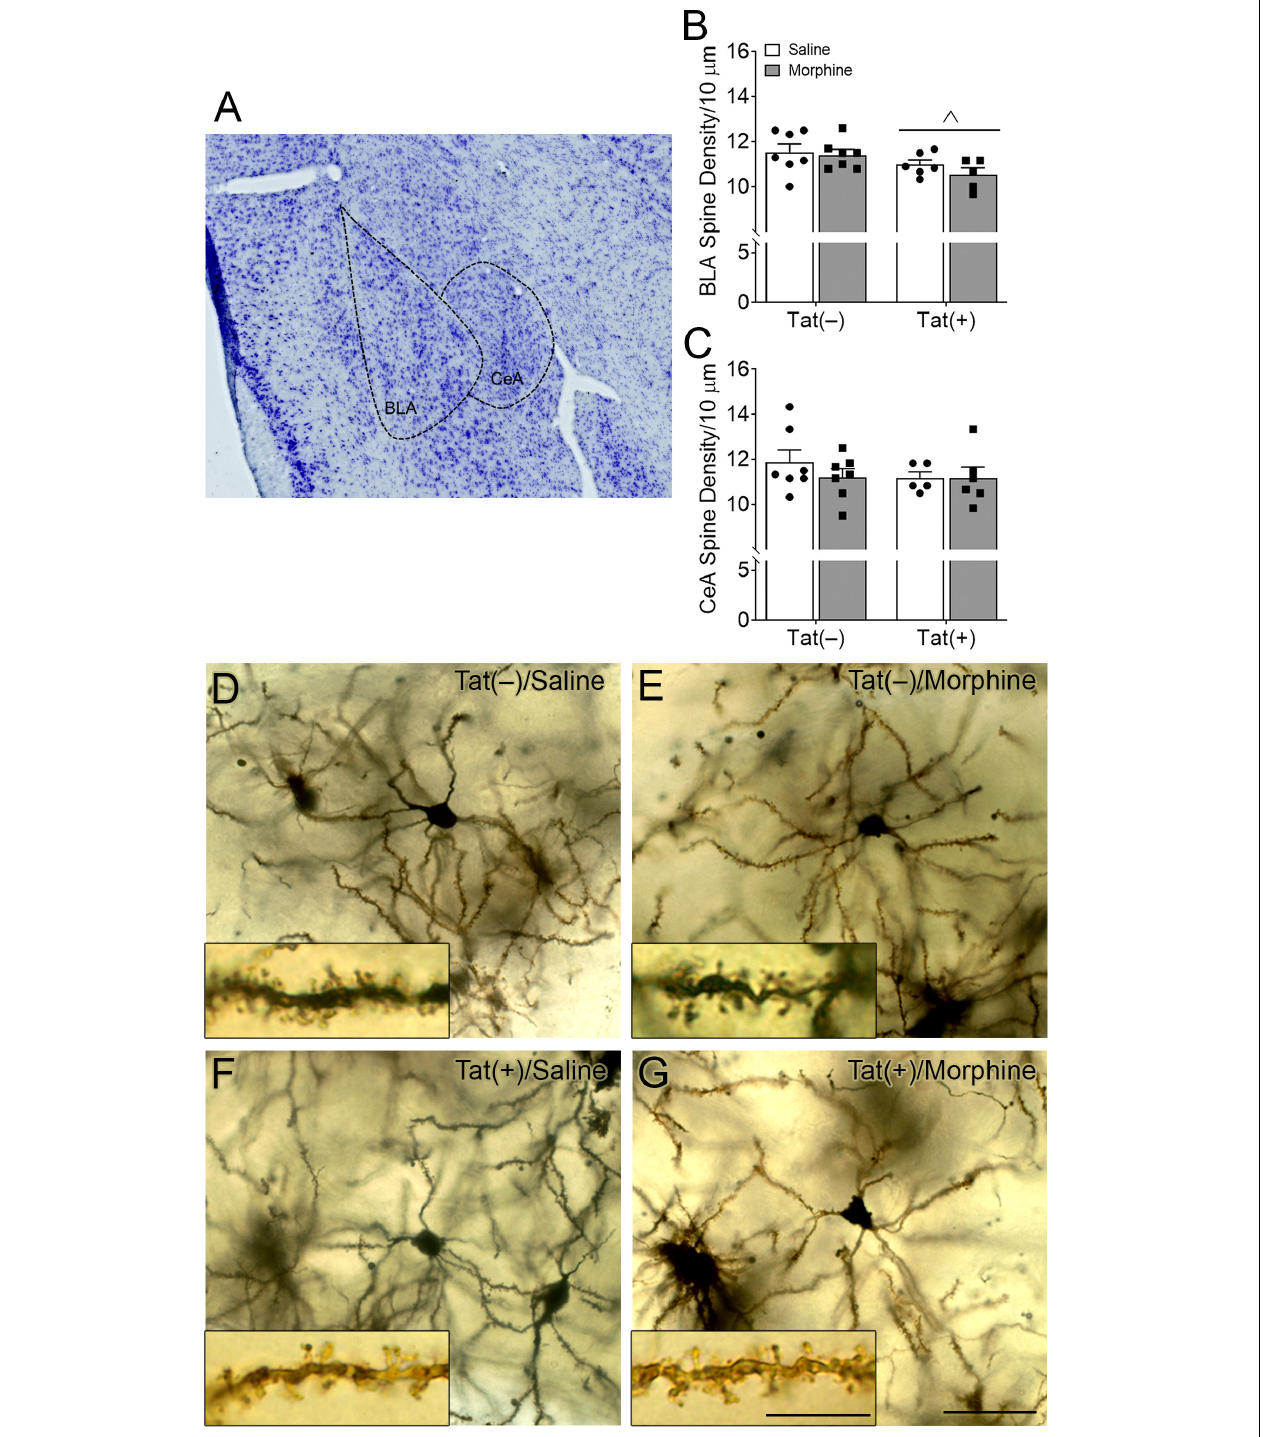
FIGURE 3 | HIV-1 Tat decreased dendritic spine density in the basolateral, but not central nuclei of the amygdala. Representative Nissl-stained image showing the basolateral (BLA) and central (CeA) nuclei of the amygdala (A) . Tat exposure for 8 weeks, regardless of repeated morphine exposure during the final 2 weeks of the experiment, decreased the dendritic spine density of pyramidal neurons in the BLA (B) , but not the density of dendritic spine in medium spiny-type neurons within the CeA (C) . Representative images of Golgi-impregnated BLA pyramidal neurons (D–G) (scale bar = 50 µ m). Appearance of pyramidal neurons and tertiary (3rd order; scale bar = 10 µ m) dendrites in the BLA following saline (D) or morphine (E) administration in Tat(–) mice, and saline (F) and morphine (G) administration in Tat(+) mice. Data are presented as the mean ± the SEM; multiple neurons ( ≥ 6) were sampled in each n = 5–7 mice per group, ∧ p < 0.05, main effect of